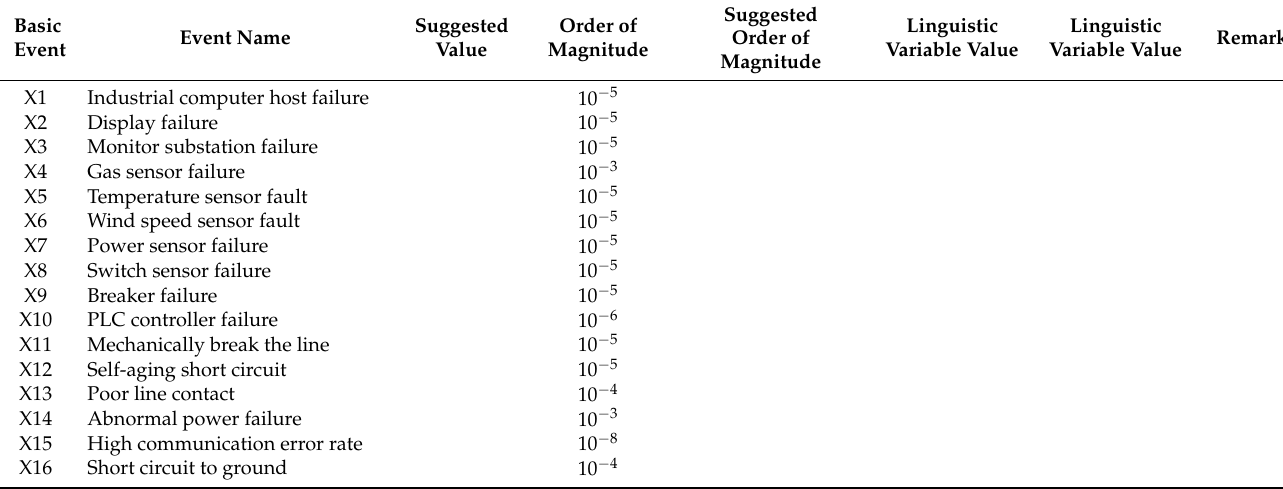
Table 2. Expert questionnaire on the probability of basic